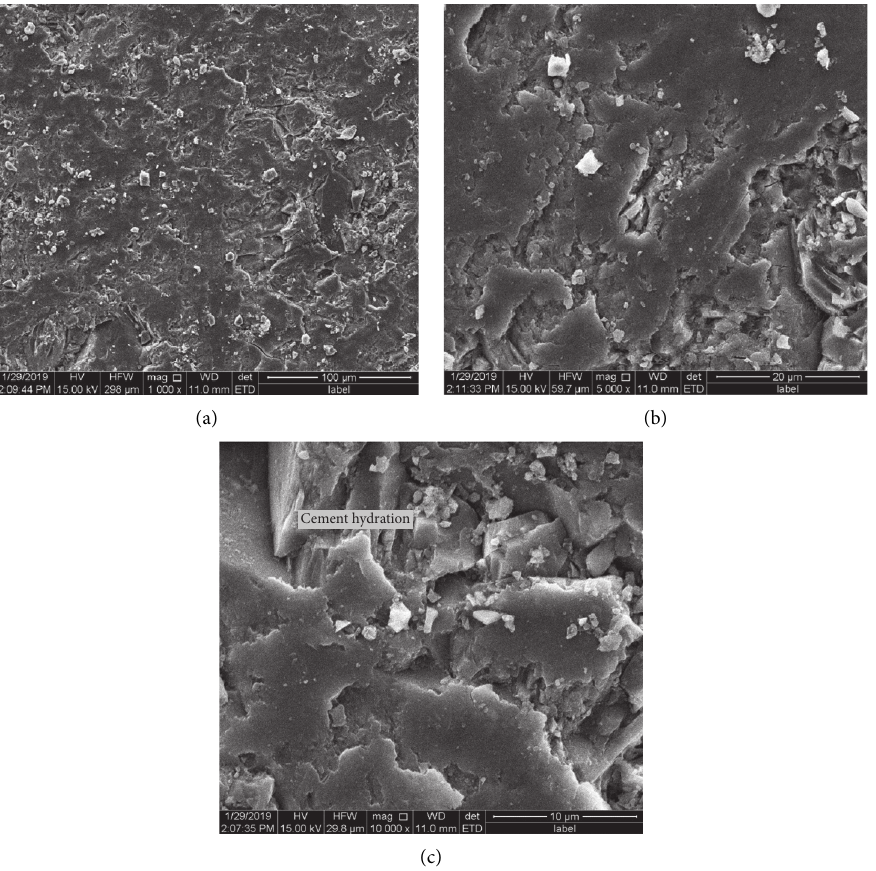
Figure 21: Morphology of SFP sample cured for 14 days. (a) Scale bar � 100 μ m. (b) Scale bar � 20 μ m. (c) Scale bar � 10 μ